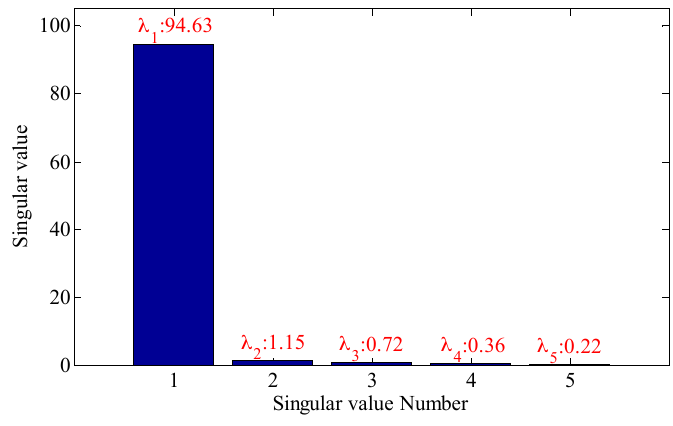
Figure 23. Singular values of the trace matrix.